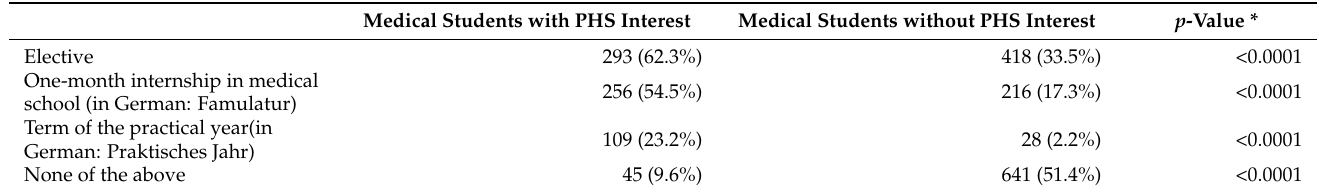
Table A8. Preferred ways to gain (practical) experience relevant for tasks and activities of the PHS among medical students in Germany: Absolute and relative proportions, taking into account multiple responses in wave 1, OeGD-Studisyurvey.